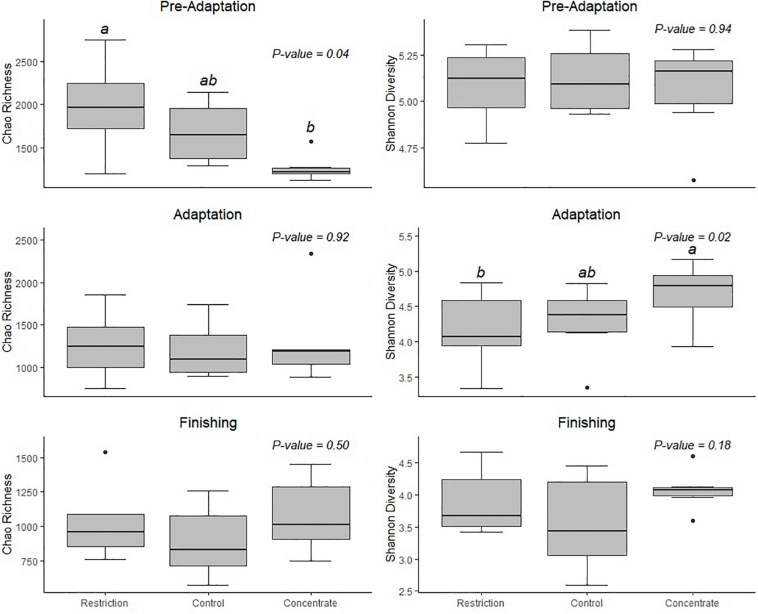
Shannon’s diversity index and Chao’s richness estimator for microbial communities in the rumen of Nellore cattle. Data are expressed as standard boxplots with medians. Outliers are shown as dots. Groups with different letters above the same plot are significantly different (Tukey’s HSD P < 0.05).